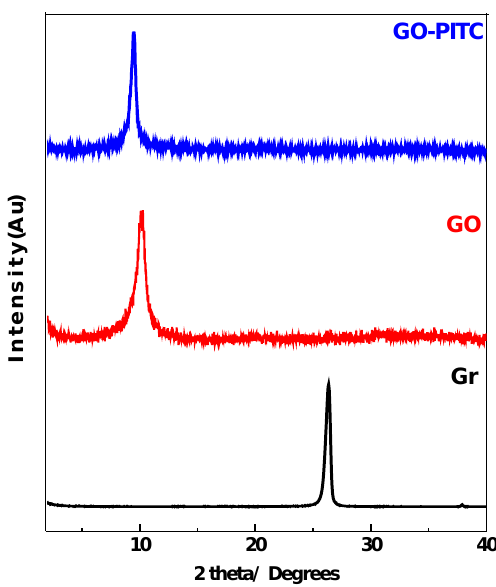
Figure 1. X-ray diffraction patterns of Graphite (Gr), graphene oxide (GO) and the GO-PEITC nanocomposite.